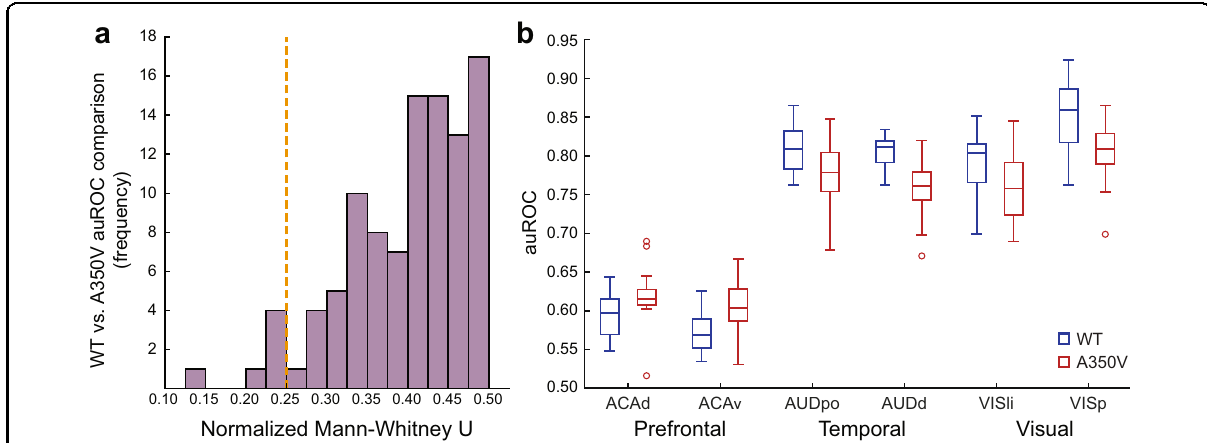
Fig. 4 Structure – function relations reveal potential altered functional connectivity in A350V relative to WT and serves as a seed selection method. a Distribution of the normalized Mann – Whitney U obtained from the comparison of the 101 cortical modules seeds between WT and A350V mice. Orange dashed line indicates the six comparisons that passed the critical normalized U value for sample size of n WT = 13 and n A350V = 13. U values were normalized to the expected maximal U value. b The area under receiver operating characteristic (auROC) curve values indicate closer agreement of structure – function relations in A350V mice ( red ) for ACAd and ACAv, and closer agreement in WT mice ( blue ) for AUDpo, AUDd, VISli, and VISp. Boxplots represent the median (center line), interquartile range (box limits), extreme data points (whiskers), and outlier (circles). ACAd anterior cingulate area, dorsal part, ACAv anterior cingulate area, ventral part, AUDpo posterior auditory area, AUDd dorsal auditory area, VISli laterointermediate visual area, VISp primary visual